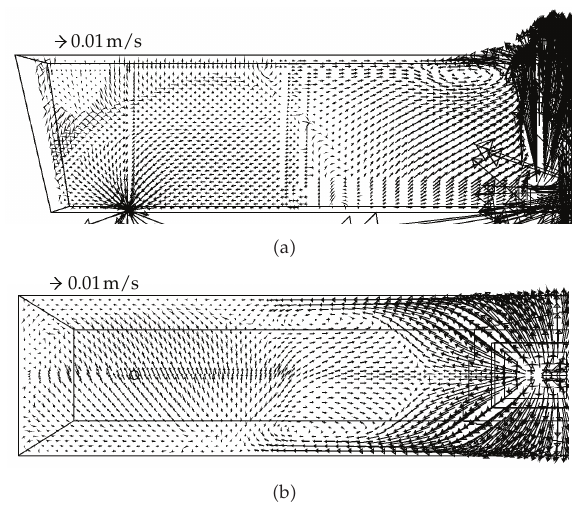
Figure 7: Velocity profiles inside the tundish without argon injection, (cid:4) a (cid:5) At the symmetric-longitudinal plane and (cid:4) b (cid:5) At the tundish steel level.